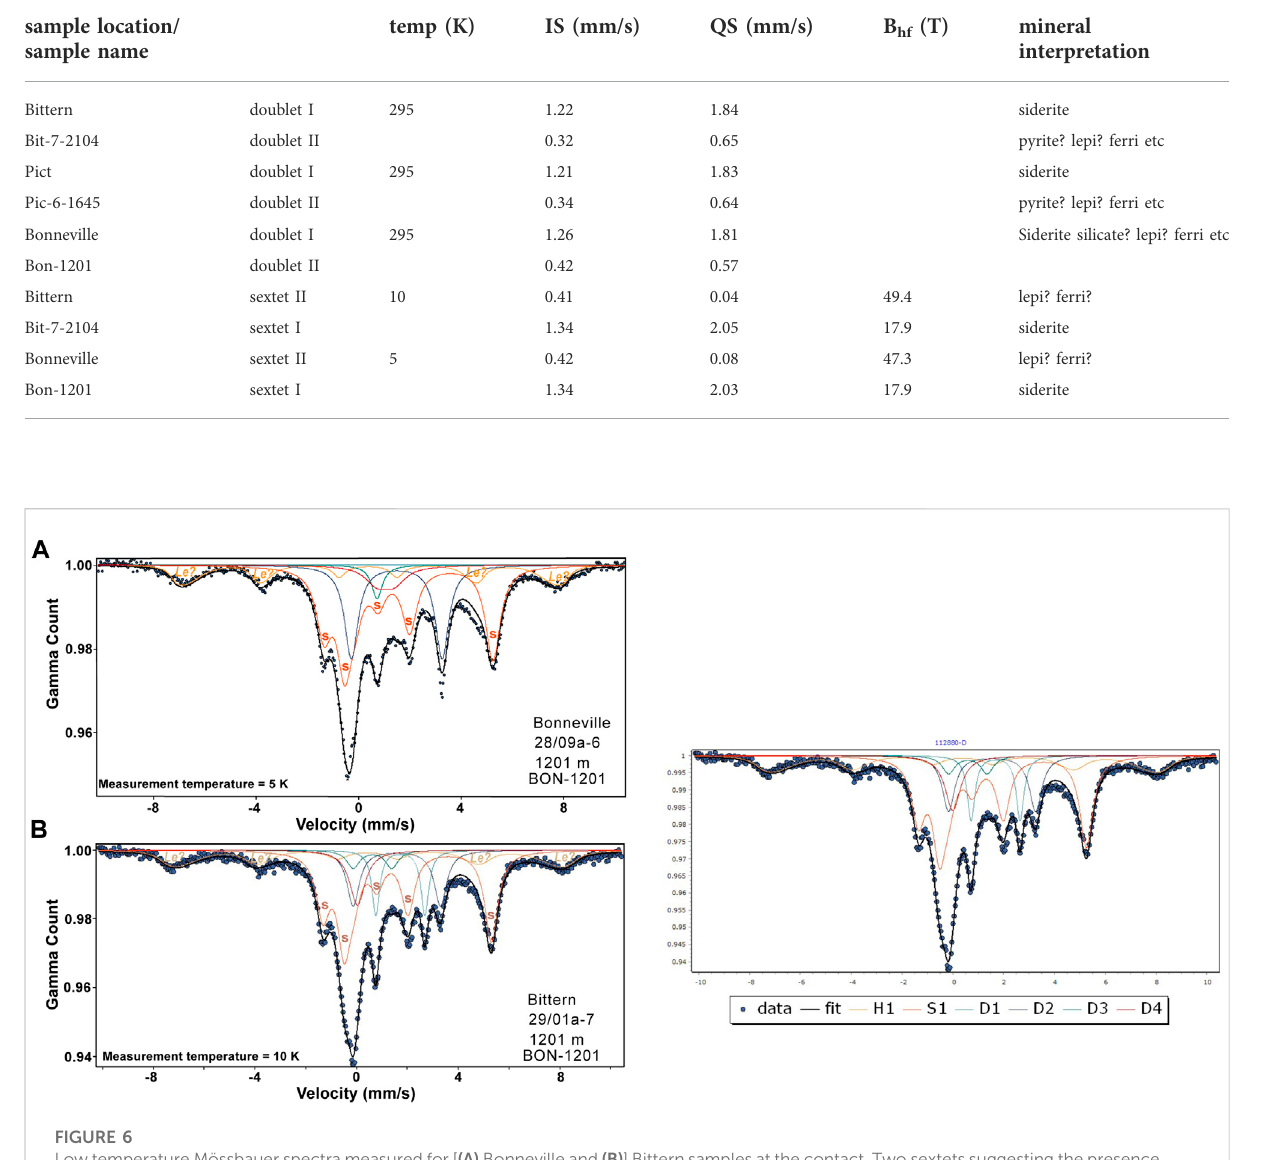
TABLE 3 Mössbauer parameters for the samples around the OWC. IS stands for isomer shift, QS stands for quadrupole splitting and B hf stands for the magnetic hyper fi ne fi eld. Lepi and ferri stands for lepidocrocite and ferrihydrite. Data from Dyar et al. (2006); Stevens et al. (2005) are applied to mineral interpretation.